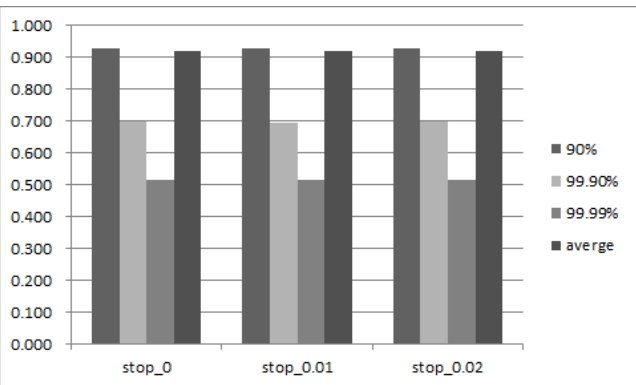
Figure 13. Sensitivity study results on the parameter of valid page ratio to invoke